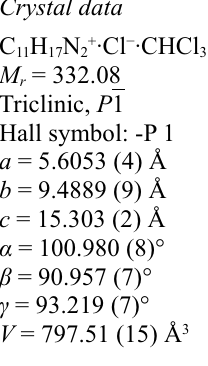
Crystal packing of the title compound showing the supramolecular arrays (hydrogen bonds as dashes lines). 4-Benzylpiperazin-1-ium chloride chloroform solvate Crystal